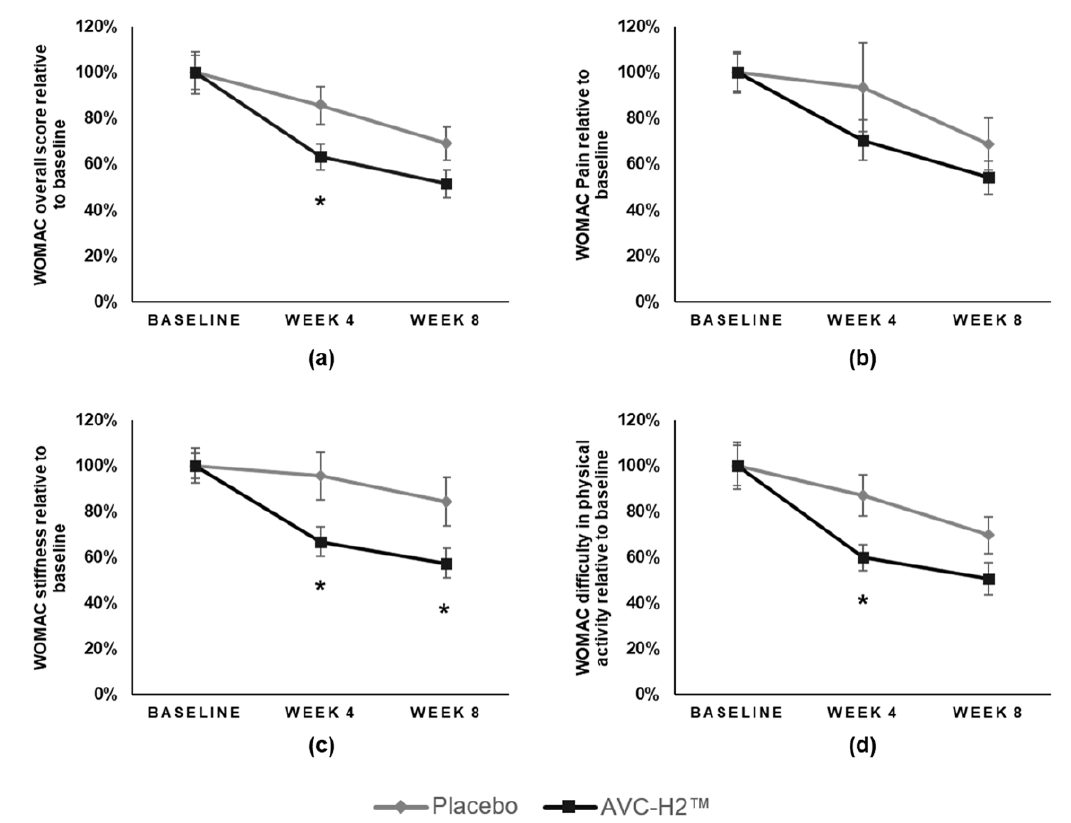
Figure 1. Relative changes in the WOMAC scores by intervention group. The graphs represented the relative change in scores from the baseline to the follow-up weeks: ( a ) WOMAC overall score; ( b ) WOMAC pain domain; ( c ) WOMAC stiffness domain; ( d ) WOMAC difficulty in physical activity domain. Baseline scores were standardized as 100% across domains for comparison purposes. Error bars represented the standard error (SE) for each group at different time points in each specific WOMAC domain. * p < 0.05 for between-group comparisons at a given follow-up time point. Abbreviations: AVC-H2, Avicenna’s Hydrolyzed Chicken Collagen Type II; WOMAC, The Western Ontario and McMaster Universities Arthritis Index.